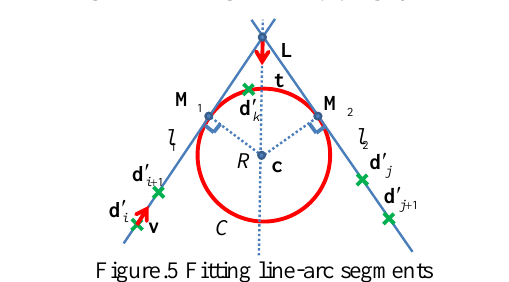
Figure.4 Tracing axes of piping system